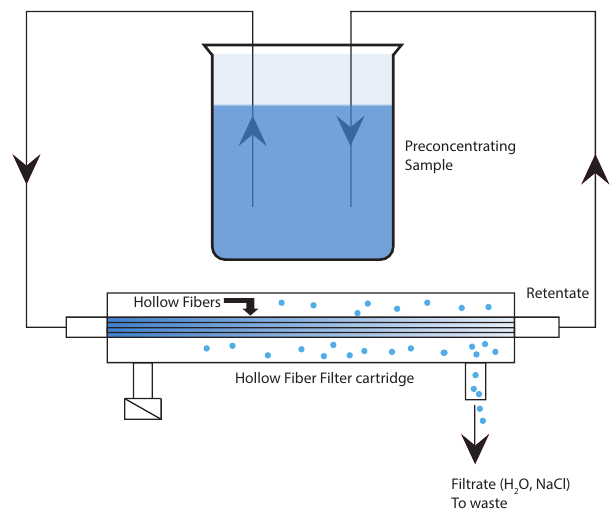
Figure 1. Tangential flow filtration setup for concentration of rain or melted ice core sample H 2 O. Water sample recirculates through the hollow fiber filter, with H 2 O and dissolved species removed through open side port of filter